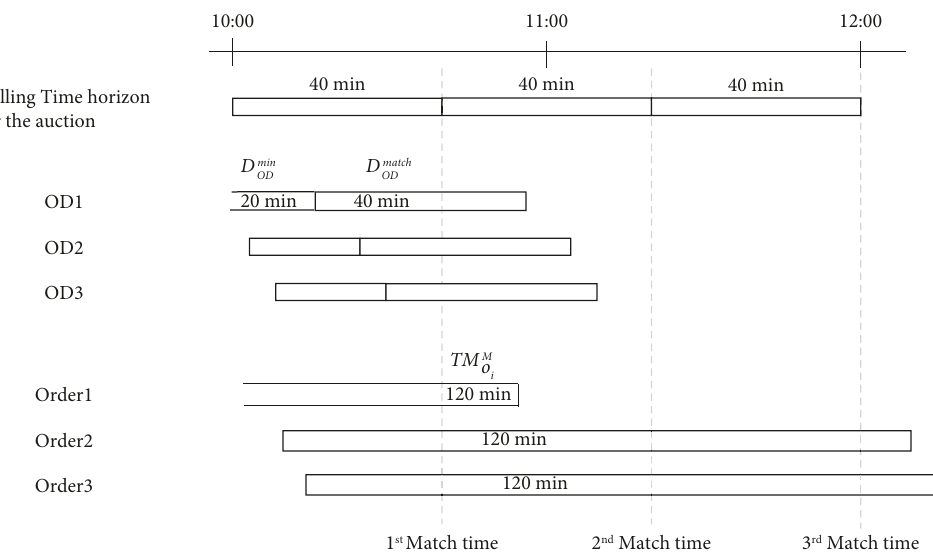
Figure 3: Relationships among rolling time horizons, ODs, and online orders at one match time